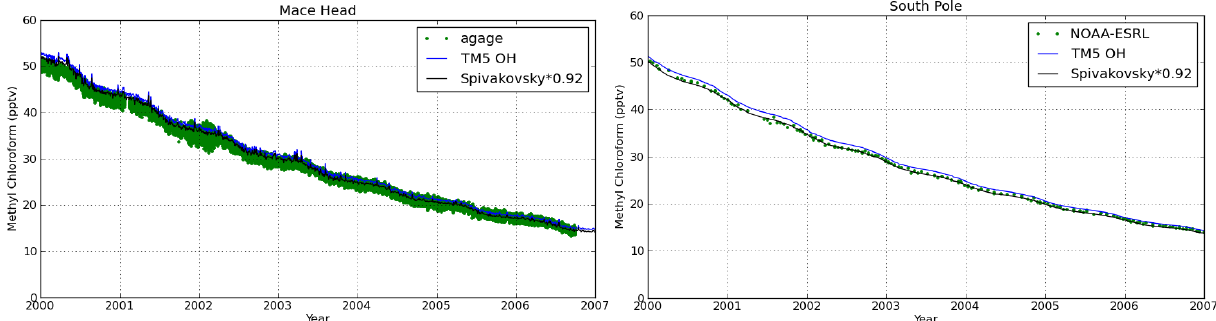
Fig. A1. Simulated methyl chloroform mixing ratios compared to observations using monthly mean OH fields from the 2006 tropospheric chemistry simulation (blue line) and from Spivakovsky et al. (2000), multiplied by 0.92 (black line). Upper panel: NOAA-ESRL station South Pole. Lower panel: AGAGE station Mace Head (Ireland).